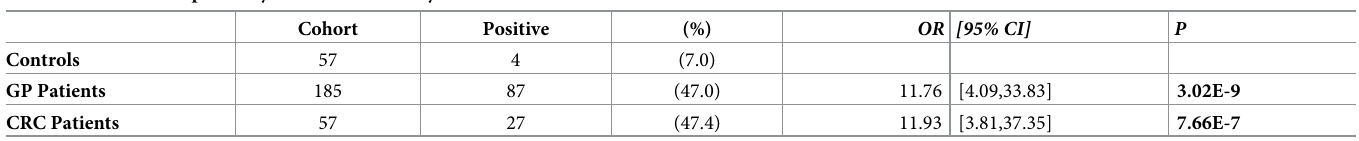
Table 1. F . nucleatum positivity relative to a healthy control cohort.